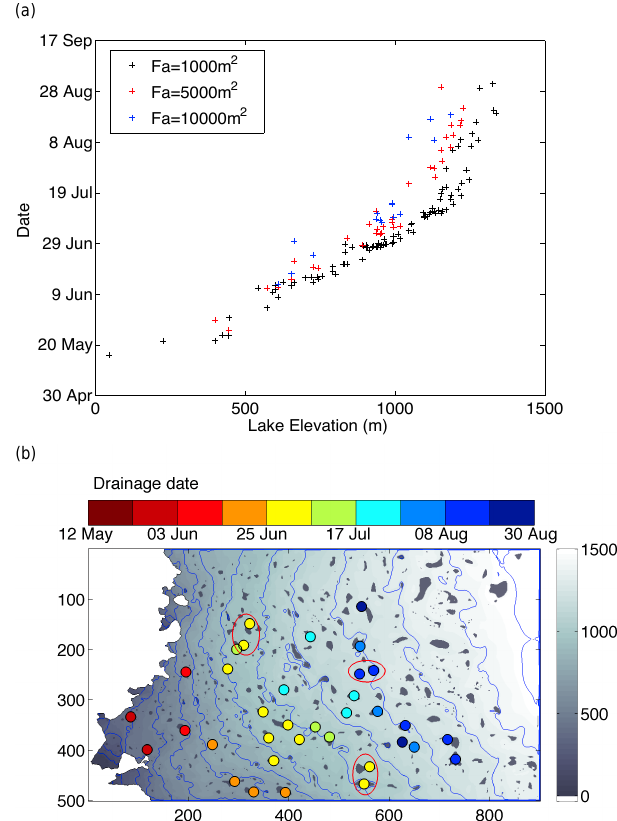
Figure 3. (a) Up-ice sheet progression of lake drainage events dur- Figure 3. a) Up-ice sheet progression of lake drainage events during 2001 for Fa = 1000 m 2 2 ing 2001 for F a = 1000m 2 (black) 5000m 2 (red) and 10000m 2 (black) 5000 m 2 (red) and 10000 m 2 (blue). b) Spatial distribution of drainage events during 3 (blue). (b) Spatial distribution of drainage events during 2001 for 2001 for Fa = 5000 m 2 . Adjacent lakes that drain within 24 hours are highlighted with red 4 F a = 5000m 2 . Adjacent lakes that drain within 24 hours are high- lighted with red